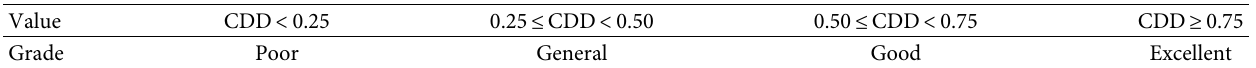
Table 2: Evaluation grade of